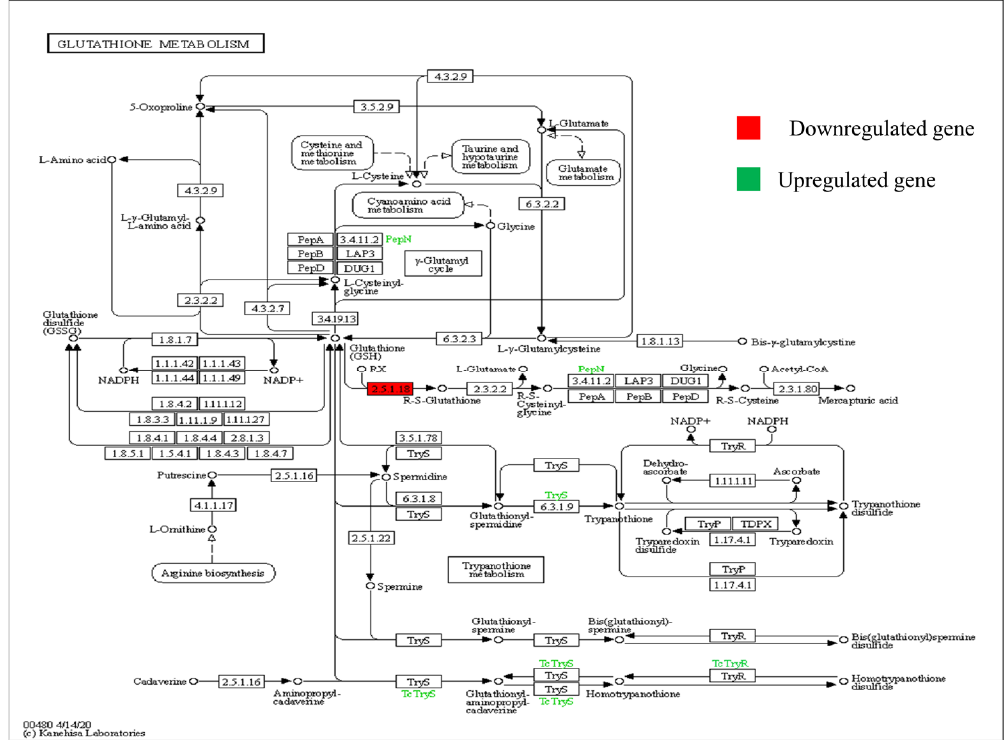
Figure 5. KEGG pathway showing regulation of glutathione-S-transferase enzyme encoded by stress-responsive significantly expressed gene (red colour showing downregulated and green colour is upregulated), p < 0.05) under heat stress.